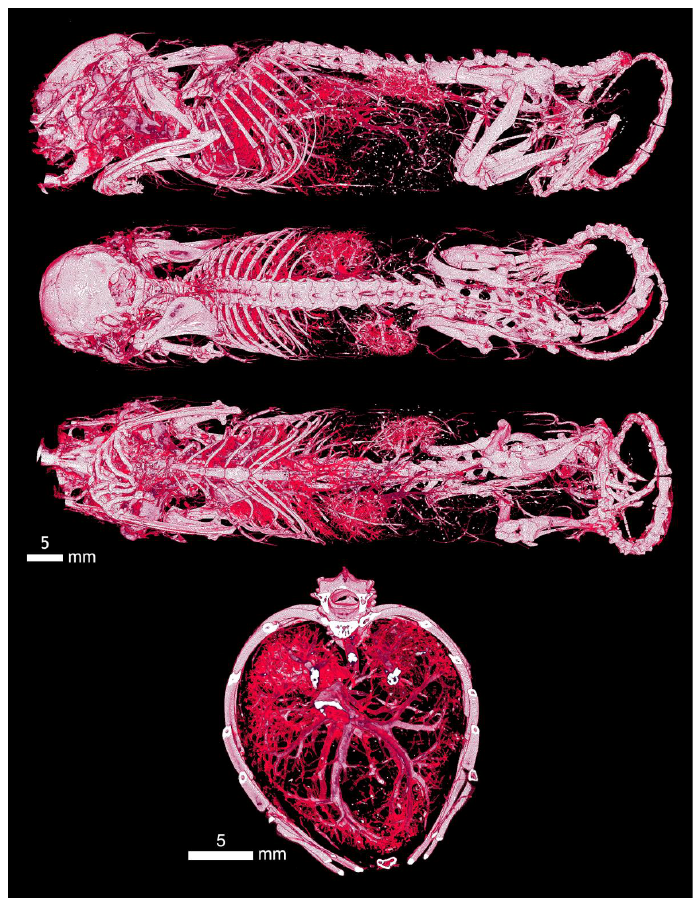
Figure A3. The Aurovist intravascular contrast displayed the entire vascular bed of the mouse. Here, is clearly visible the vasculature of the kidneys and their placement in the retroperitoneum on the sagittal section, the vessels of the thoracic organs, the hepatic vessels of all lobes, and the supply of the intestines in the abdominal cavity and pelvic plexus. In the section at the level of the thorax, there is a detail of the pulmonary system, where, according to the symmetry of the distribution and branching of the vessels, we can also describe their loss due to occlusion.